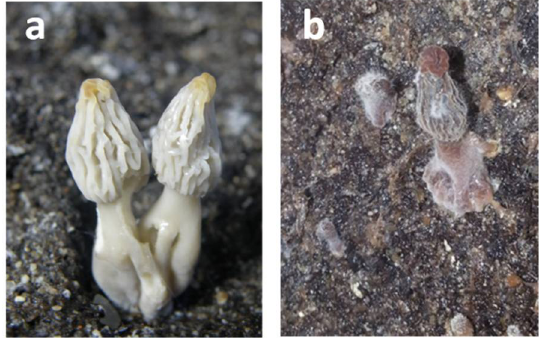
Figure 1. Healthy ( a ) and infected ( b ) young fruiting bodies of M. rufobrunnea .